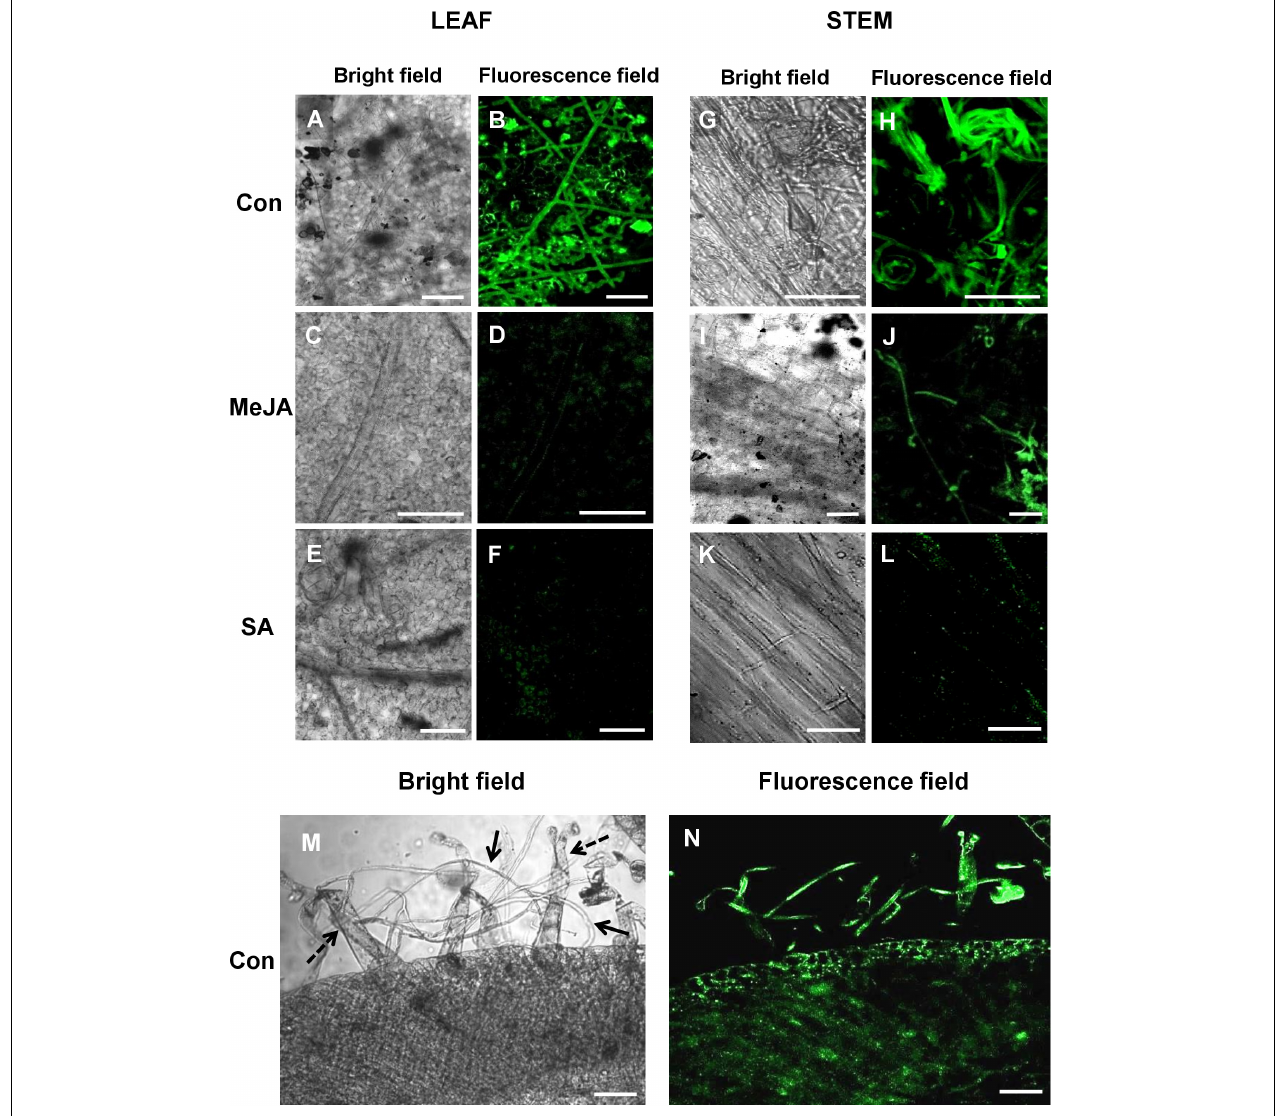
FIGURE 6 | Confocal Laser Scanning Microscopy (CLSM) of R. solani transformed with green fluorescence protein gene ( gfp ) on infected tomato leaves and stems showing avoidance of primed plants, especially SA-primed plants at 24 hpi. (A,B) CLSM of control tomato leaves showing profuse hyphal growth with infection cushions in close contact with the leaf surface. (C–F) JA and SA-primed leaves show significantly less growth of hyphae at 24 hpi. (G–L) Confocal microscopy of stems of primed and control plants infected with transformed R. solani showing least growth on SA-primed stem. (M,N) Transverse section of infected control stem showing significant interaction of hyphae (solid arrows) with stem-surface trichomes (dashed arrows) and infection within tissue at 24 hpi. Representative fluorescence fields were chosen from at least three independent plants. Bar = 50 µ